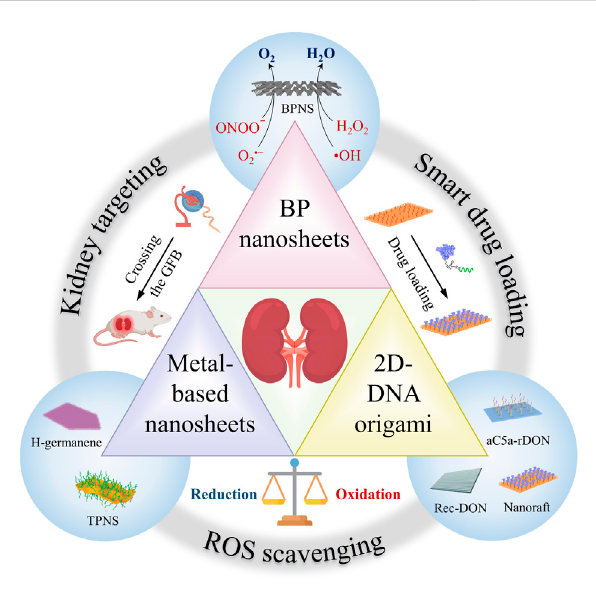
FIGURE 1 Schematic illustration of 2D nanomaterials for AKI treatment. In recent years, several emerging 2D nanomaterials have demonstrated excellent therapeutic effects in AKI due to their excellent kidney targeting, smart drug loading and ROS scavenging capabilities, including 2D-DNA origami, metal-based nanosheets and BP